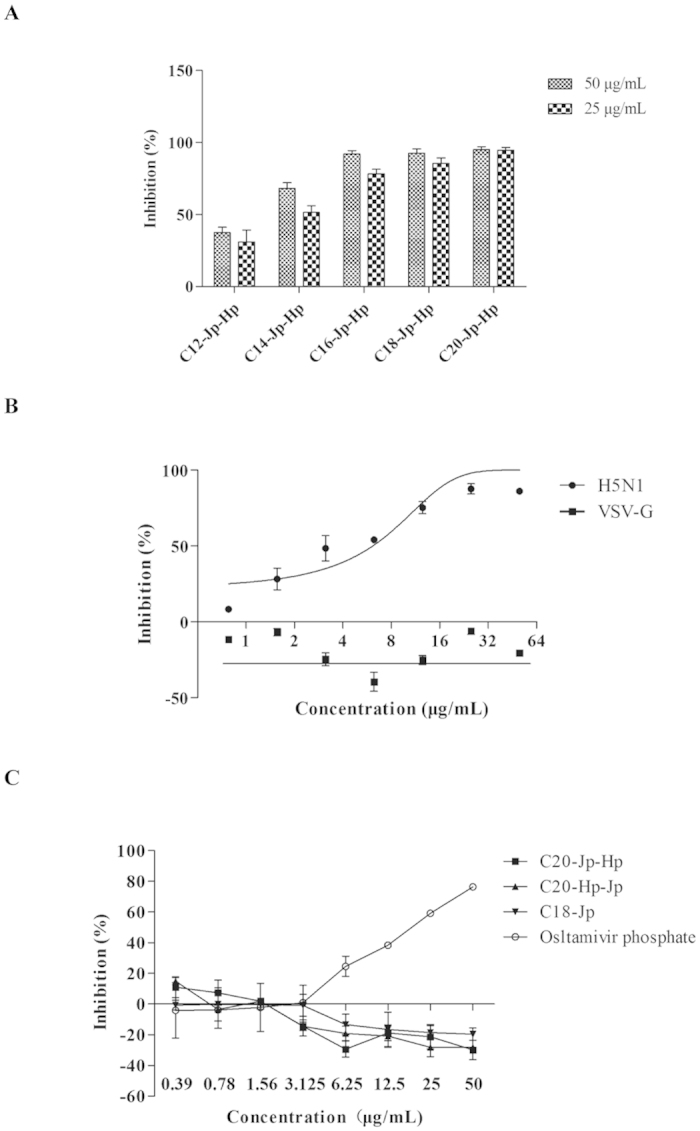
(A) Inhibition of the infectivity of H5N1 pesudovirus by Cn-Jp-Hp (n = 12, 14, 16, 18, 20) peptides. The peptides in various concentrations were incubated with pseudo-typed particles for 30 min at 37 °C, before transferred to the MDCK cells. The mixture of virus, peptide and MDCK cells was incubated for another 48 h, and then the luciferase activity corresponding to the survival of viruses was measured in a microplate luminometer. (B) The VSV-G pseudovirus was constructed by employing VSV-glycoprotein encoded plasmid similar to that of H5N1 pseudovirus. C20-Jp-Hp was serially two-fold diluted from 50 to 0.78 μg/mL in culture medium and then incubated with VSVG pseudovirus at 37 °C for 30 min prior to transferring into the MDCK cells. With the same procedure as that of H5N1 pseudovirus, the inhibitory effect toward VSVG pseudovirus was determined. As a comparison, C20-Jp-Hp at various concentrations inhibiting the infectivity of H5N1 pseudovirus was used in the same experiment. Each data was expressed as the mean of three independent replicates. (C) Neuraminidase (NA) inhibition assay. The neuraminidase from influenza A/Puerto Rico/8/34 (H1N1) virus was used in this experiment. The reaction mixture consisting of the tested peptides and virus in MES buffer was incubated for 45 min, and then 4-MU-NANA was added into each reaction well. The cleavage reaction was conducted for an additional 1 h, then terminated with 100 μL 34 mM NaOH (83% ethanol). The resulting fluorescence of the mixture was recorded at the excitation wavelength of 340 nm and emission wavelength of 440 nm. Oseltamivir phosphate was employed as positive control.